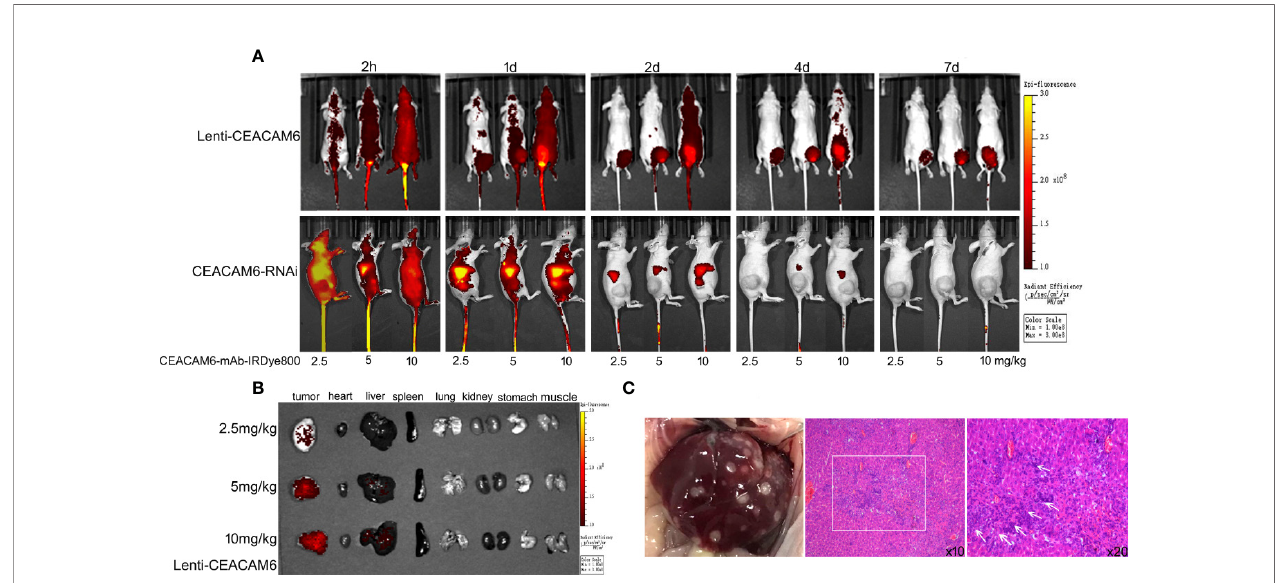
FIGURE 6 | (A) The MKN − 45 cells infected with Lenti-CEACAM6 or CEACAM6 RNAi were used to derive the subcutaneous tumor mice model, for the in vivo imaging study, the CEAACM6-mAb-IRDye800CW probe with the concentration of 2.5, 5 and 10 mg/kg was injected in the caudal vein of the mice respectively, the fl uorescence intensity were observed at 2 h until 7 days, and the tissues which were expressed the CEACAM6 highly were labeled by the probe and showed the red signals. (B) After imaging, the mice were euthanasia the tumor, heart, liver, spleen, lung, kidney, stomach and muscle were removed and imaged, the tissues which were expressed the CEACAM6 highly were labeled by the probe and showed the red signals. (C) The surface change of the liver got above, the HE staining was applied to study the histology of liver, the metastases was showed in the white box, and the cancer cells were indicated with white